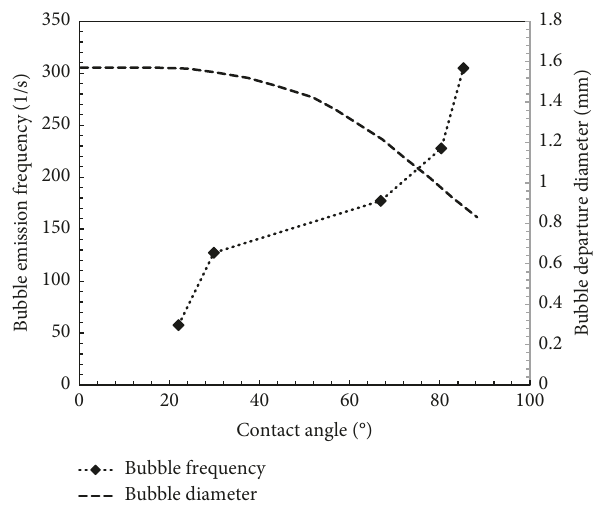
Figure 13: Frequency of bubble departure and bubble diameter versus the contact angle [23,